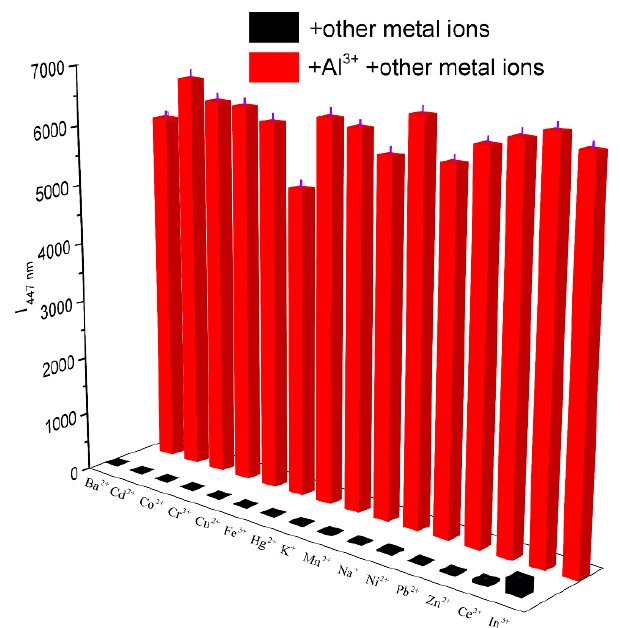
Figure 4. Bar graph of fluorescence intensity at 447 nm of PEGBAB (10 µ M) with and without Al 3+ (2 equiv.) in the presence of other competitive metal ions (2 equiv.) in aqueous